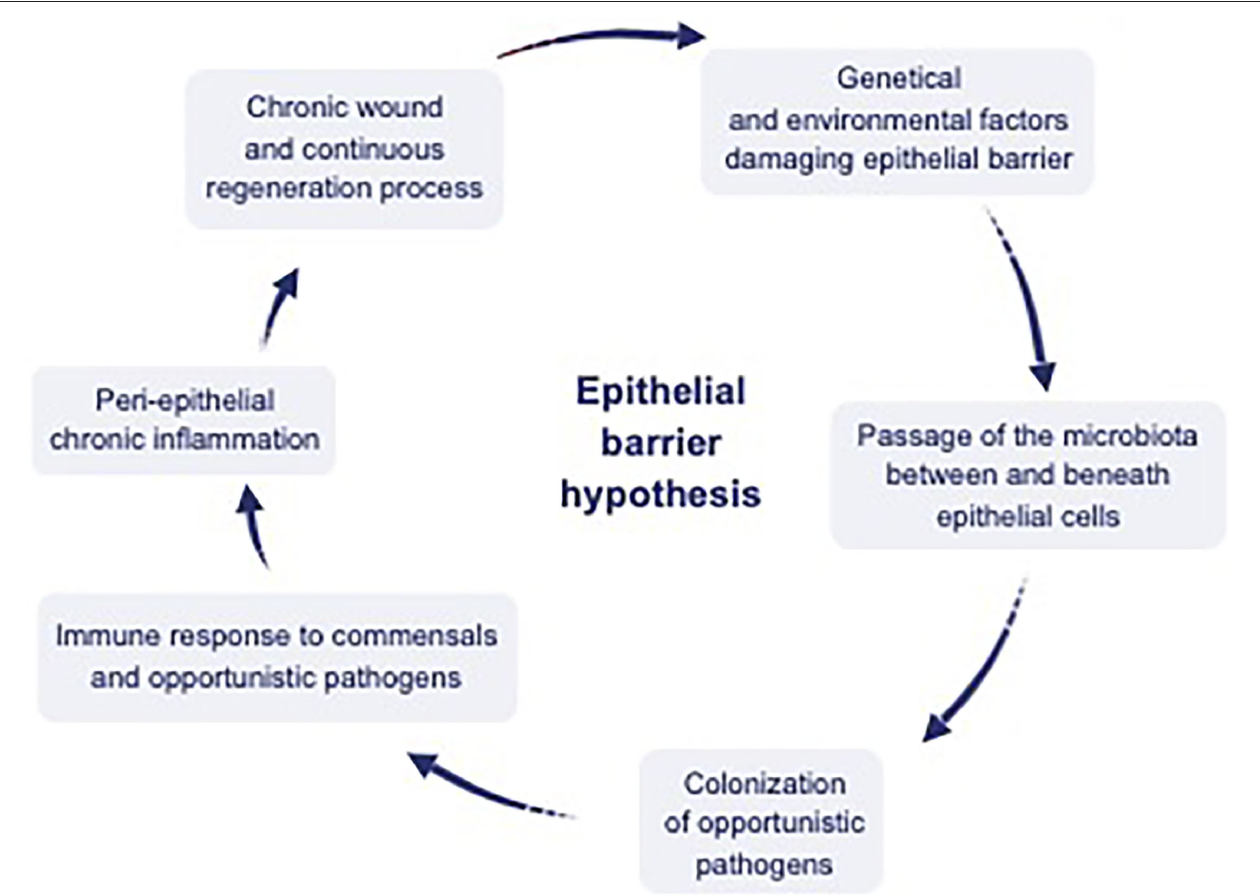
FIGURE 2 | Interaction between environmental factors, epithelium, microbiota, and the immune system. Dysregulation of the epithelial barrier by genetic and environmental factors has been hypothesized to cause a leaky epithelium, which causes dysbiosis of microbial content, including commensals and opportunistic pathogens. Translocation of this content to interepithelial and subepithelial compartments and colonization of the opportunistic pathogens inducing peri-epithelial chronic inflammation. Finally chronic wound and continuous regeneration process ensues [adapted from reference